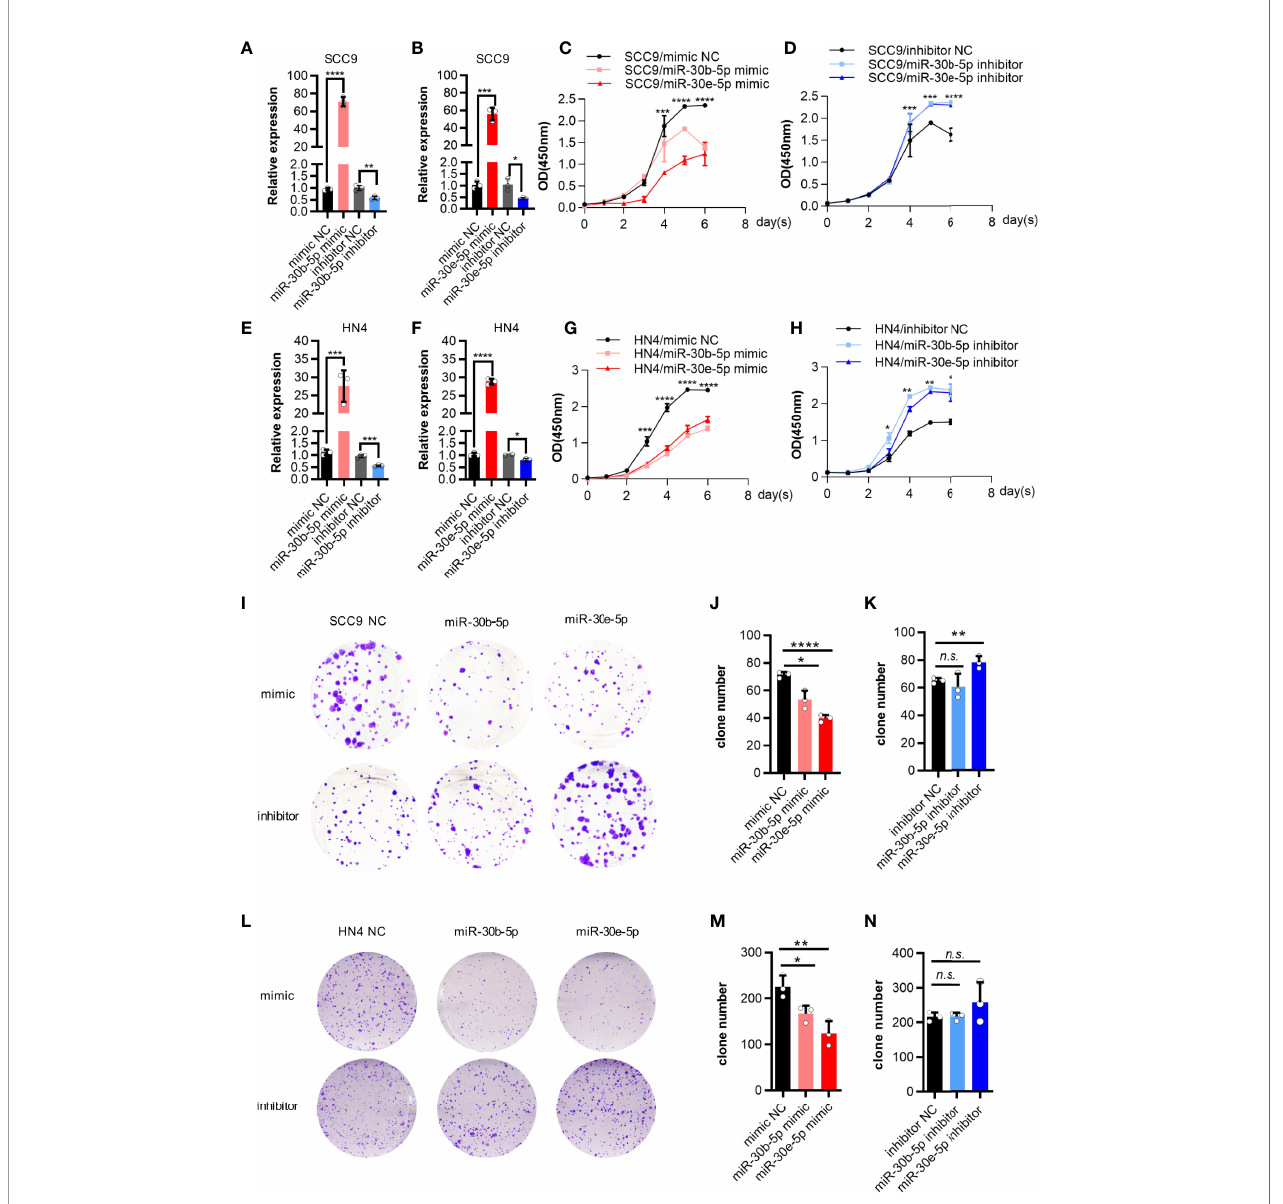
FIGURE 3 | The proliferation of SCC9 and HN4 cells was depressed by miR-30b-5p or miR-30e-5p. (A) The expression level of miR-30b-5p in SCC9 cells after transfection with miR-30b-5p mimic or inhibitor. (B) The expression level of miR-30e-5p in SCC9 cells after transfection with miR-30e-5p mimic or inhibitor. (C) The proliferation of SCC9 cells after transfection with miR-30b-5p or miR-30e-5p mimic. (D) The proliferation of SCC9 cells after transfection with miR-30b-5p or miR- 30e-5p inhibitor. (E) The expression level of miR-30b-5p in HN4 cells after transfection with miR-30b-5p mimic or inhibitor. (F) The expression level of miR-30e-5p in HN4 cells after transfection with miR-30e-5p mimic or inhibitor. (G) The proliferation of HN4 cells after transfection with miR-30b-5p or miR-30e-5p mimic. (H) The proliferation of HN4 cells after transfection with miR-30b-5p or miR-30e-5p inhibitor. (I – K) The colony formation of SCC9 cells depressed by miR-30b-5p or miR- 30e-5p. (L – N) The colony formation of HN4 cells depressed by miR-30b-5p or miR-30e-5p. (* p <0.05, ** p <0.01, *** p <0.001, **** p <0.0001, n.s., no signi fi